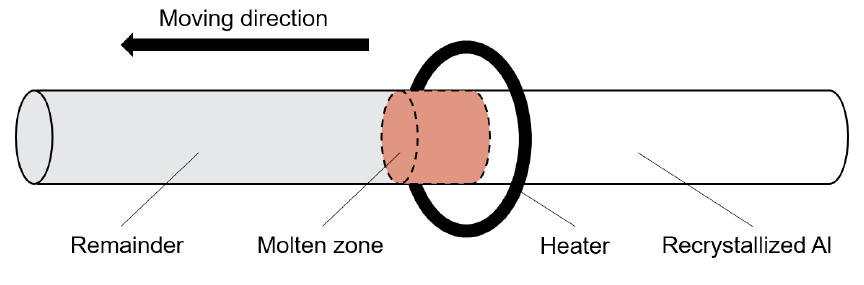
Figure 9. Structural representation of the zone-refining process with a single heater. Zone Length